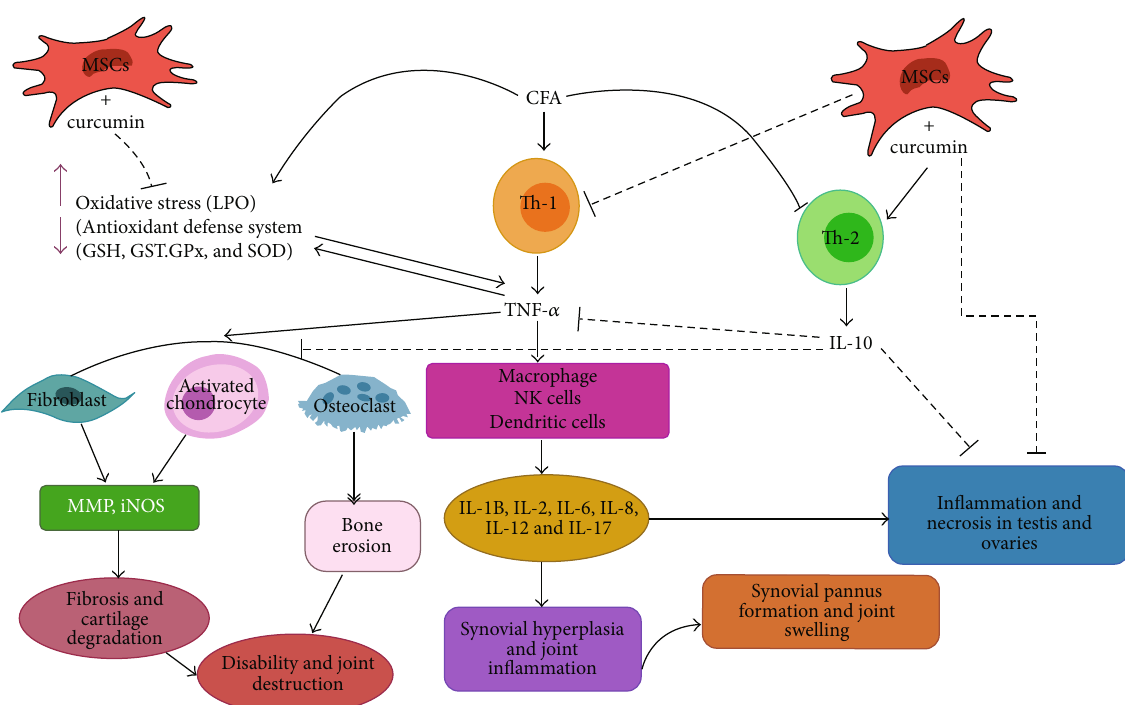
Figure 10: Schematic fi gure showing the mode of actions of CFA to induce arthritis via increasing LPO and TNF- α (Th1 cytokine) and decreasing IL-10 (Th2), thereby resulting in synovial hyperplasia and joint, testis, and ovary necrosis, and in fl ammation. The treatment with curcumin and/or MSCs can counteract these actions via enhancing the antioxidant defense system and anti-in fl ammatory mechanisms. → : activation; ┴ :